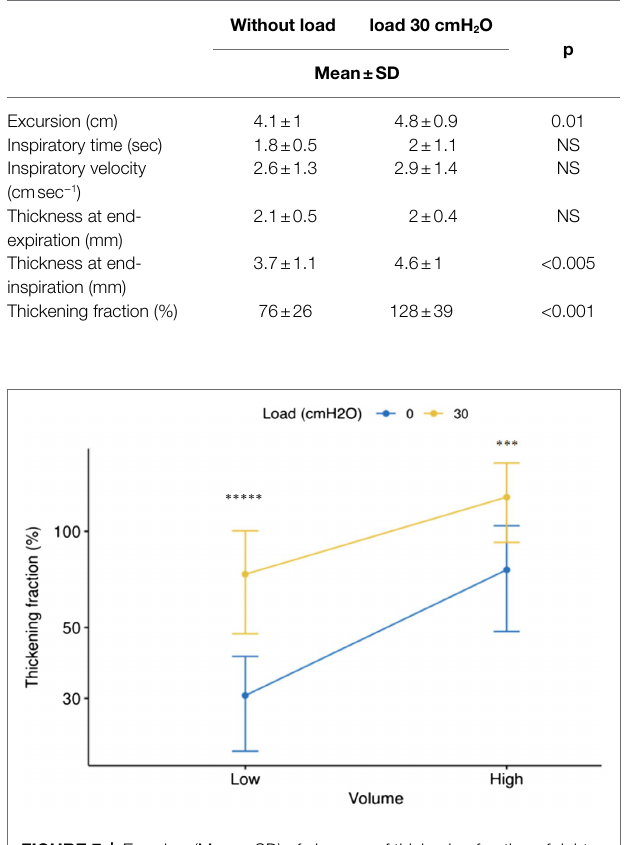
FIGURE 7 | Error bar (Mean ± SD) of changes of thickening fraction of right hemidiaphragm (Log10) in the sessions with and without load at low (tidal volume) and high volume (50% of inspiratory capacity). ***** p < 10 − 11 , *** p < 0.001.